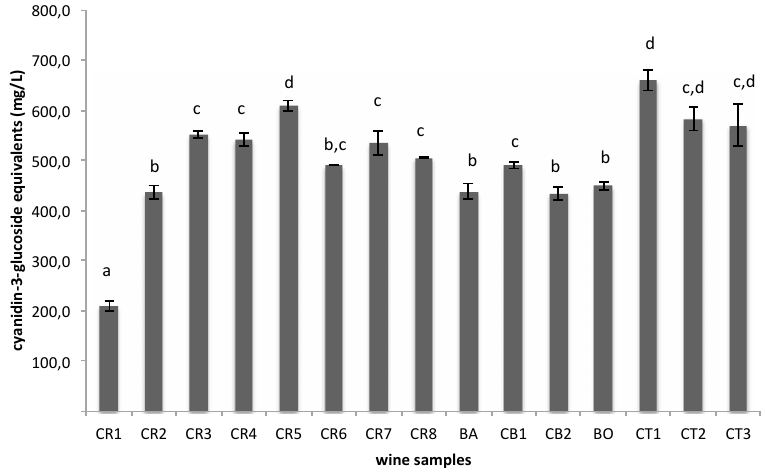
Figure 2. Total monomeric anthocyanin content of the 15 wine samples obtained by pH-differential method assay. Data (mg/L CGE) are expressed as the mean ± SD ( n = 3); different letters indicate statistically significant differences ( p < 0.05) between samples.